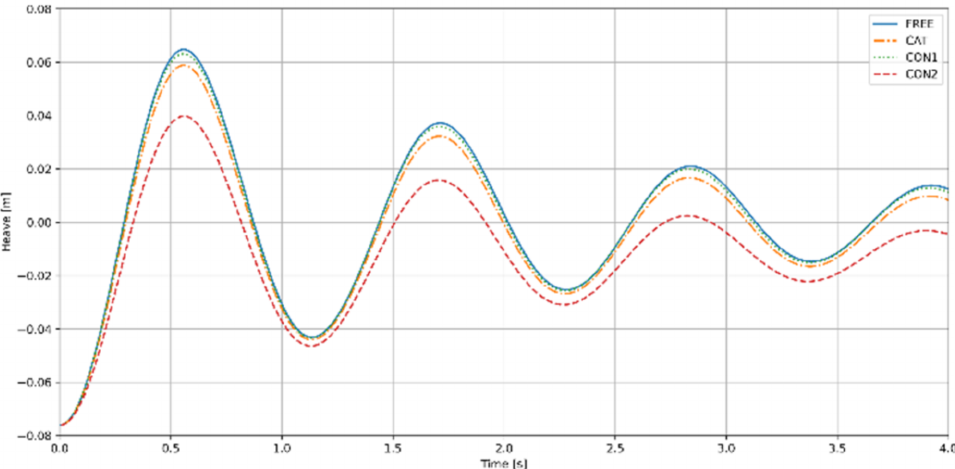
Figure 10. Comparative time histories of heave motion obtained from decay tests of the free buoy and of the buoy with mooring systems CAT, CON1, and